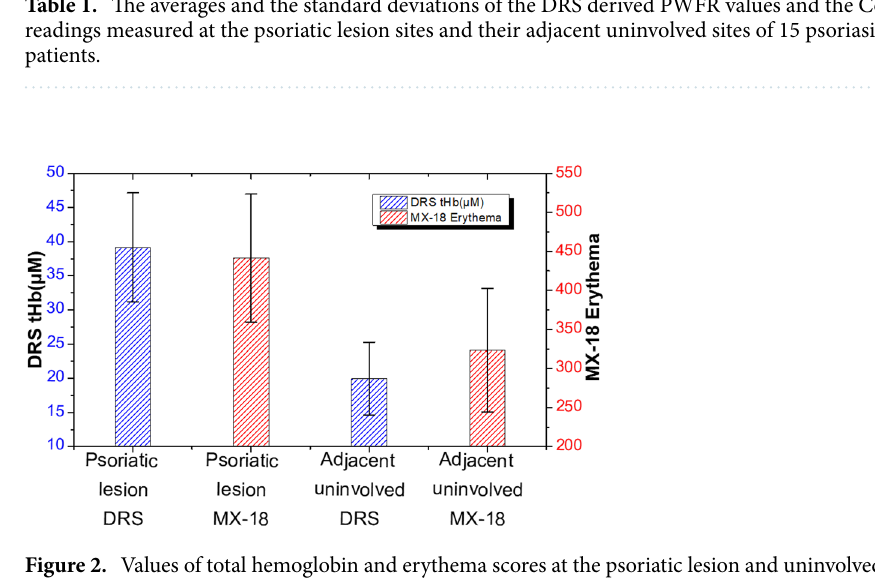
Figure 2. Values of total hemoglobin and erythema scores at the psoriatic lesion and uninvolved sites of 15 subjects obtained from DRS and